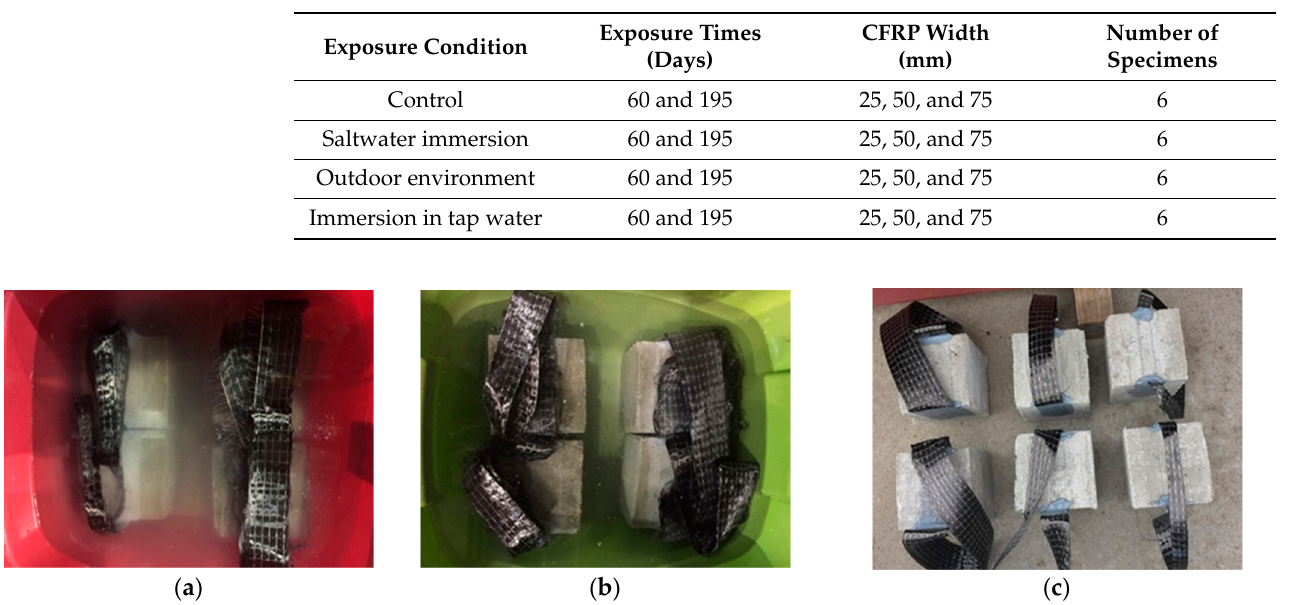
Table 1. Summary of exposure conditions used to weather the specimens.